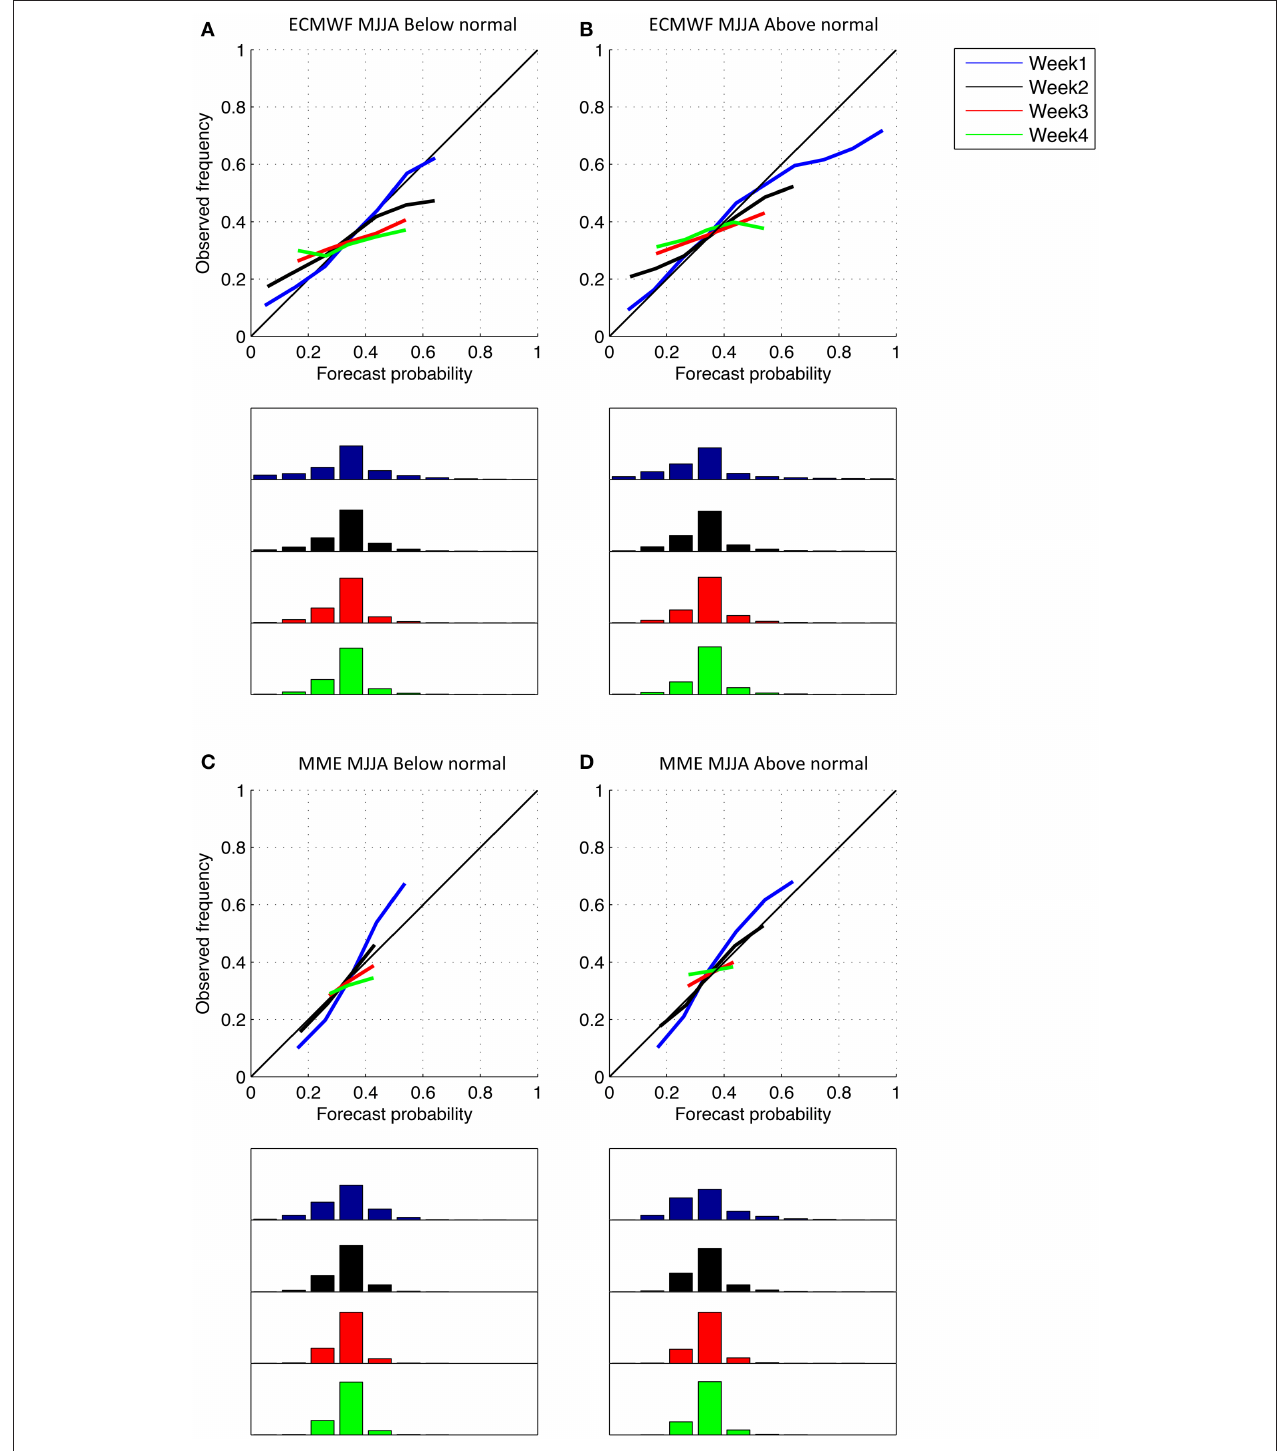
FIGURE 4 | Similar to Figure 2 but for landpoints of the Asian monsoon region shown in Figure 7 .